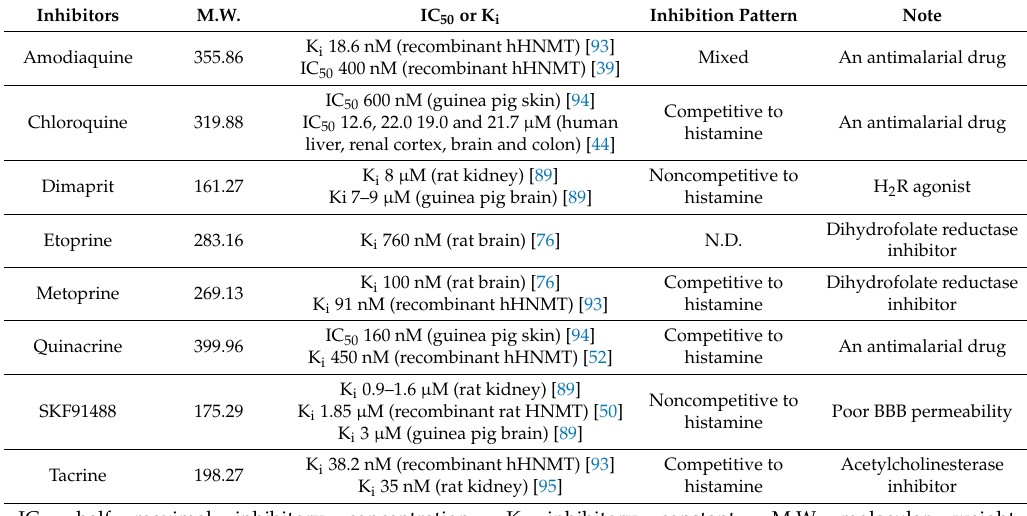
Table 3. Characteristics of HNMT inhibitors.